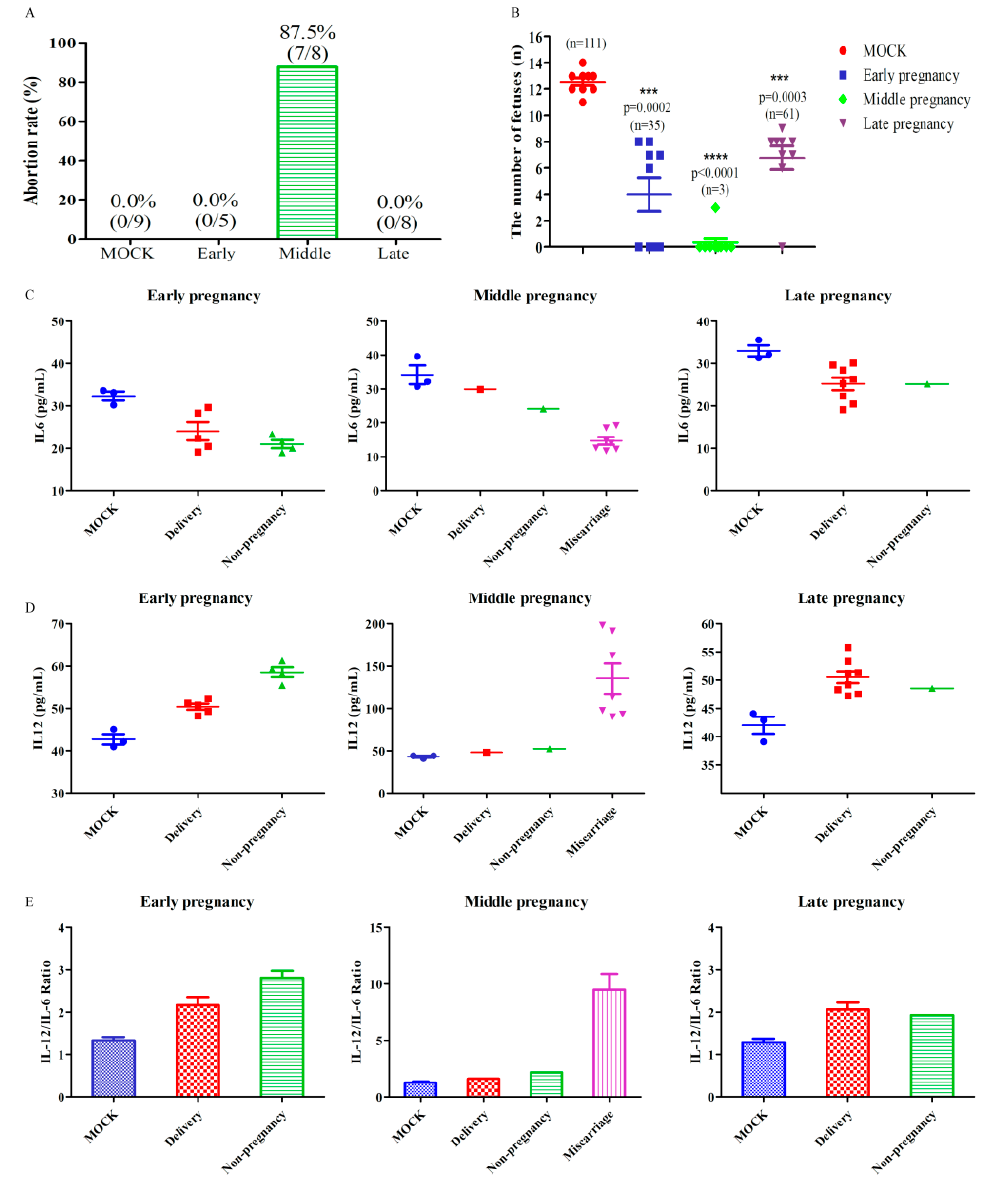
Figure 4. HEV infection leads to adverse pregnancy outcomes. (A) The rate of abortion. (B) The number of fetuses from an uninfected or HEV ‐ infected mother. The concentration of IL ‐ 6 (C) and IL ‐ 12 (D) in the serum of mice with or without HEV infection. (E) The IL ‐ 12/IL ‐ 6 ratio in pregnant mice with or without HEV